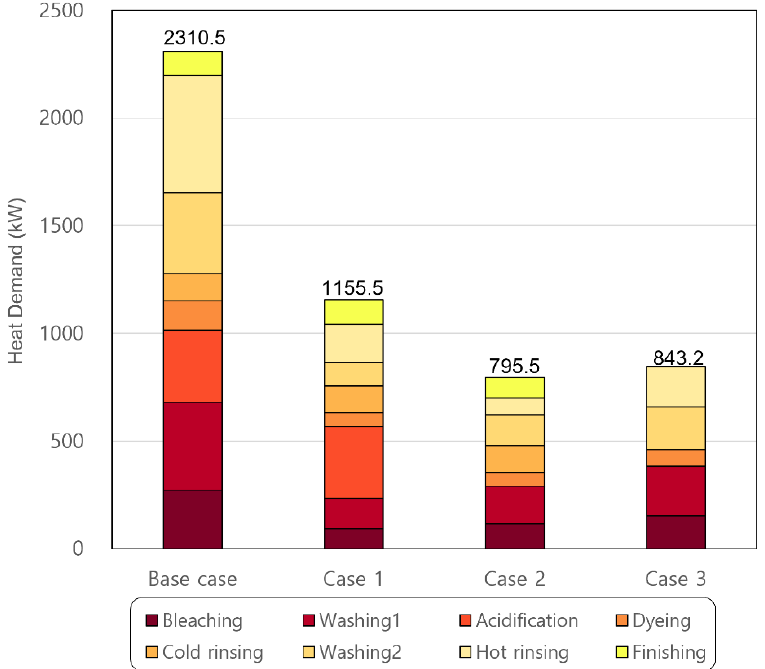
Figure 3. Heat demand of each case.